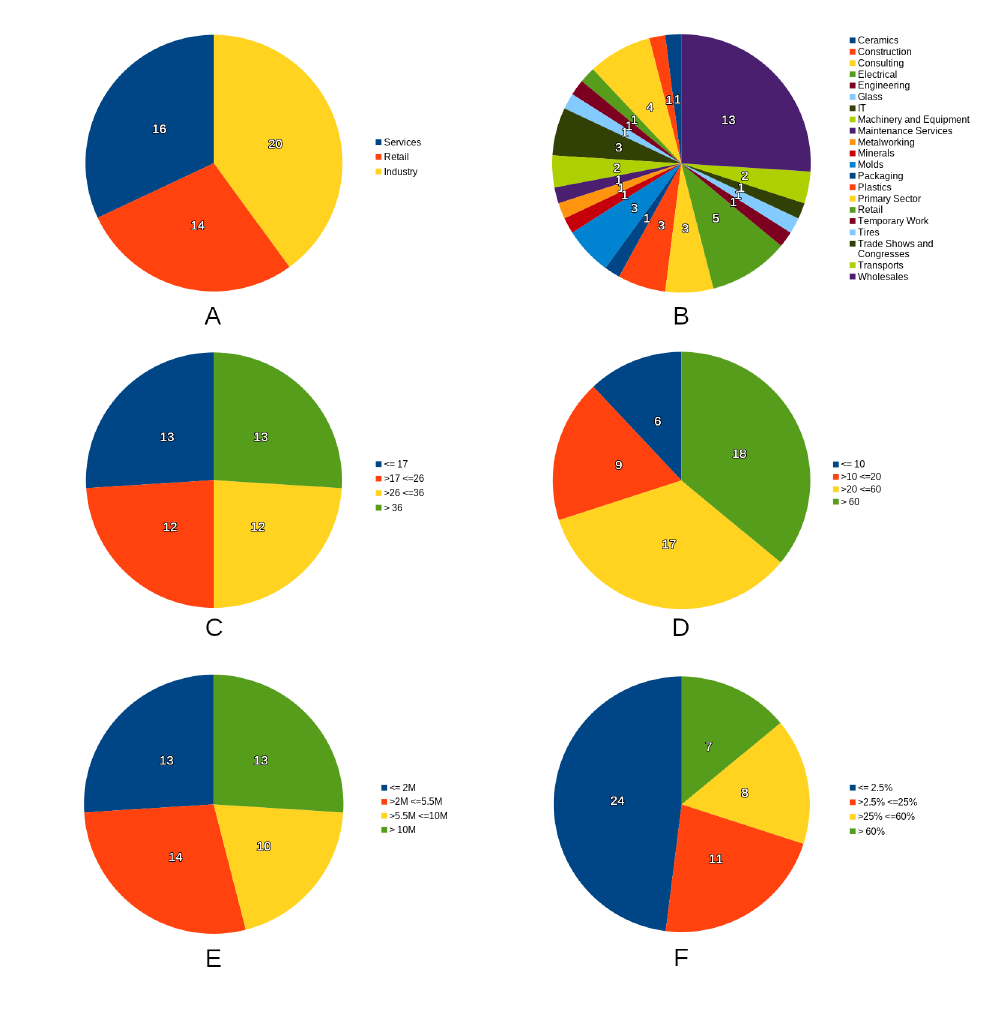
Figure 2. Characterization of the SMEs participating in the case study—( A ) Main activity sector; ( B ) sub-sectors of activity; ( C ) age of the enterprise; ( D ) number of employees; ( E ) business revenue (scale); and, ( F ) exports as % of business revenue